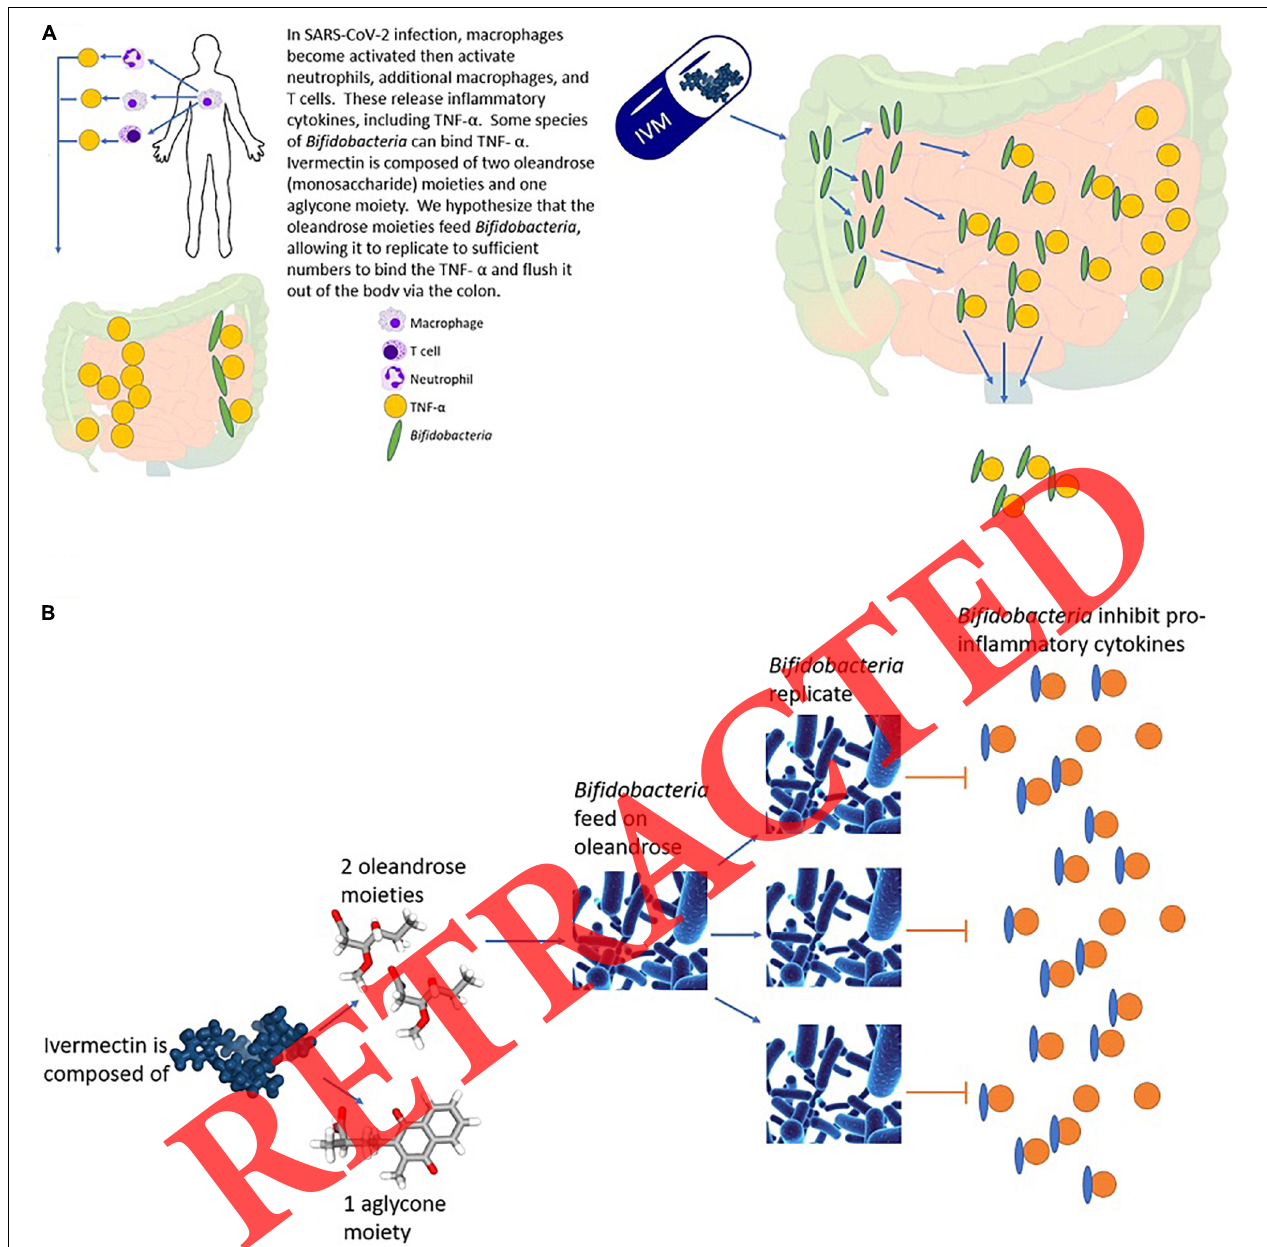
FIGURE 1 | We hypothesize that IVM treats SARS-CoV-2 infection by decreasing inflammation through enhanced replication of Bifidobacterium , leading to inhibition of TNF- α . (A) Bifidobacterium inhibits inflammation via binding of TNF- α . (B) Expansion of the right side of panel (A) , showing IVM contains monosaccharide oleandrose moieties that could feed Bifidobacterium , thereby increasing replication and increasing inhibition of TNF- α and inhibition of